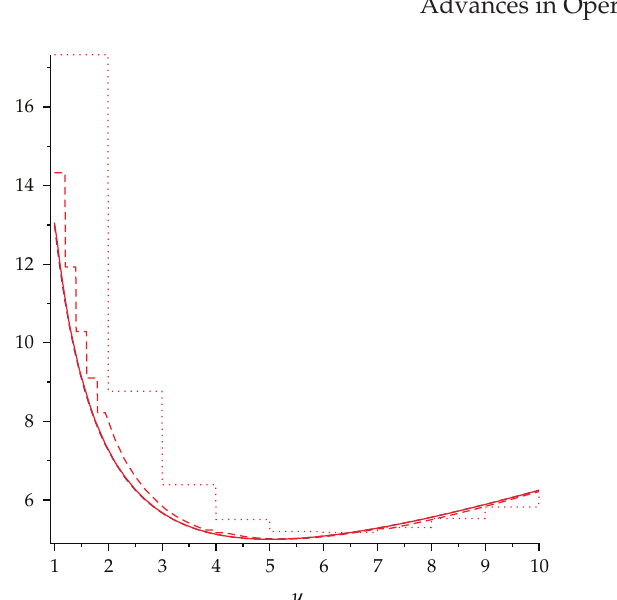
Figure 1: The dotted line (cid:2) resp., dashed line, solid line (cid:3) corresponds to 1 TCU (cid:2)(cid:5) y (cid:6)(cid:3) (cid:2) resp., 5 TCU (cid:2)(cid:5) 5 y (cid:6)(cid:3) , tcu (cid:2) y (cid:3)(cid:3)